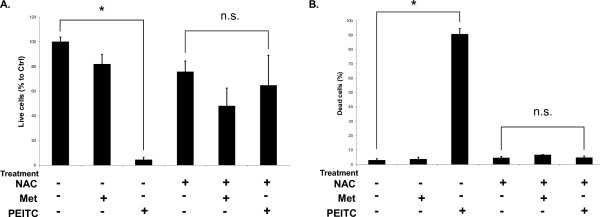
NAC supplementation reverses PEITC cell death.A. The effect of NAC supplementation on control (DMSO vehicle), metformin [5 mM], and PEITC [5 μM] growth inhibitory effects on PA-1 cell line after 24 hours. Metformin is relatively unaffected by the addition of NAC, while PEITC's growth inhibition is significantly reduced. B. The dead cell percent of PA-1 cells treated with control (DMSO vehicle), metformin, or PEITC treatment with and without NAC pre treatment. Metformin alone does not induce high amounts of cell death with or without NAC. PEITC's cell death is strongly reduced to levels similar to control when pretreated with NAC to act as an ROS scavenger. * p < 0.01; n.s. = not significant.